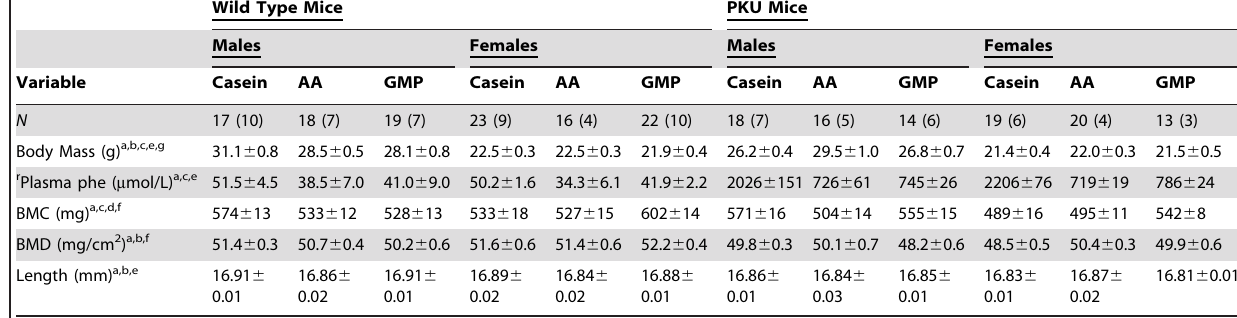
Table 1. In vivo